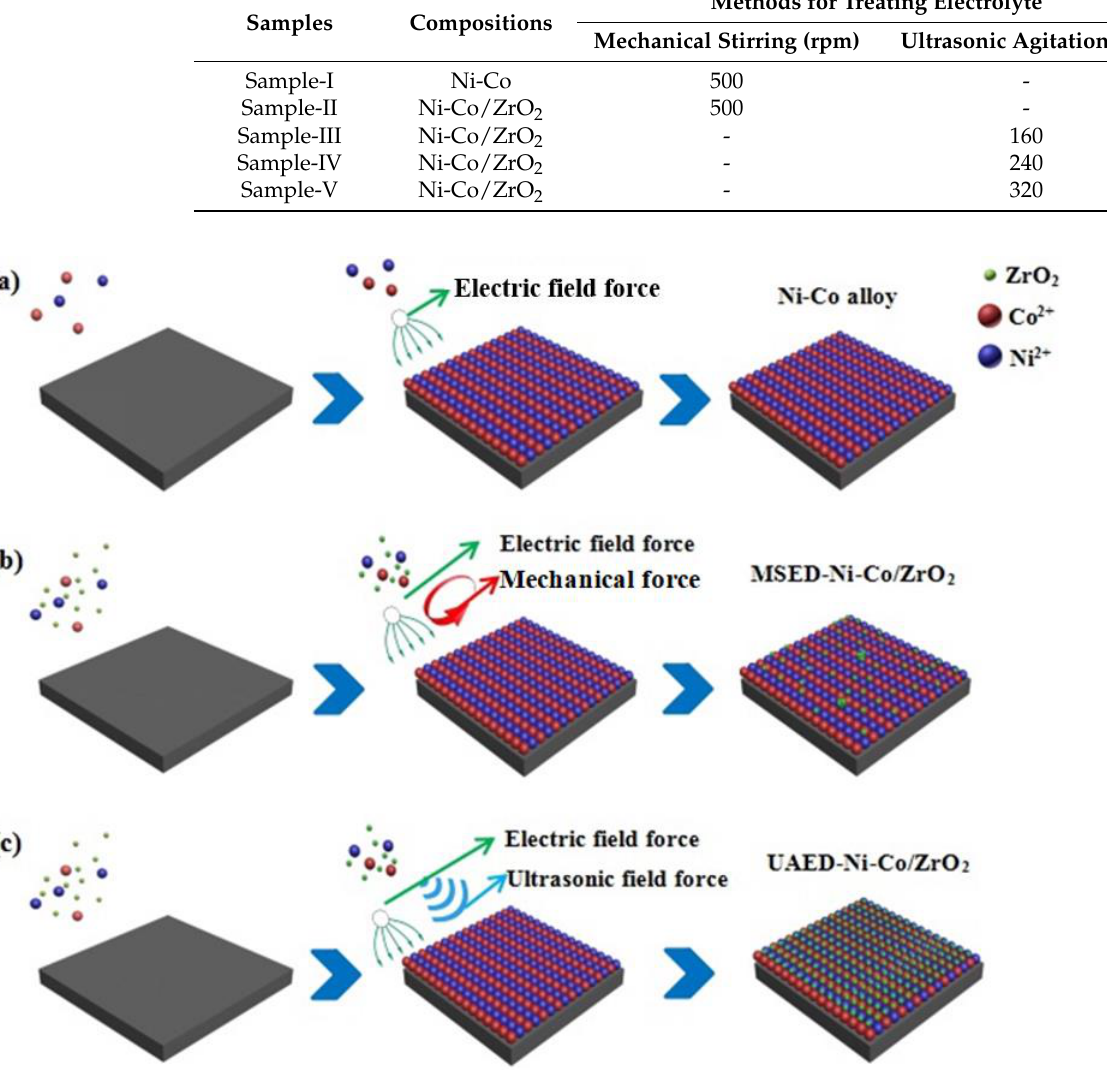
Figure 2. The flowcharts of the composite coatings under different external fields: ( a ) sample-I, ( b ) sample-II, ( c )